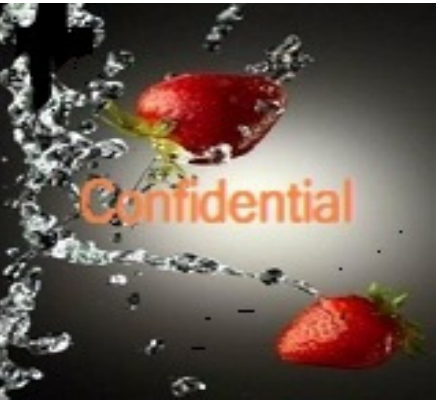
Figure 3. An example of a visible watermarked image [9].